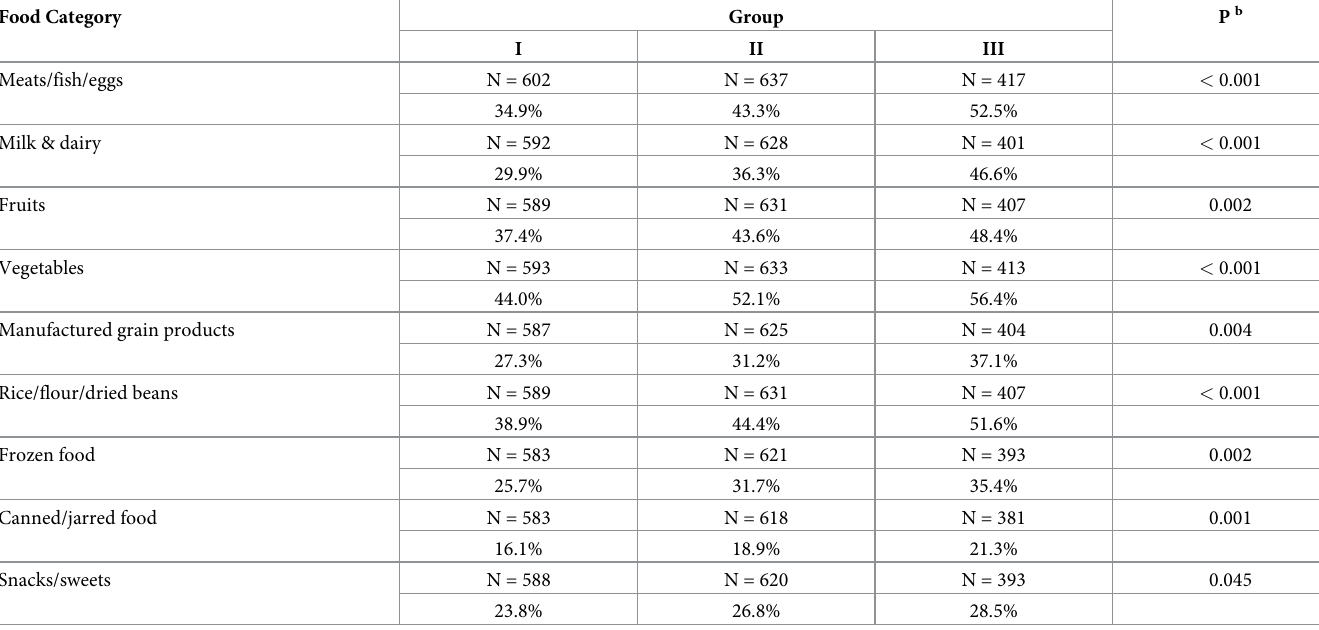
Table 2. Percentage of survey participants reporting extra food purchases during the COVID-19 home quarantine compared to before the